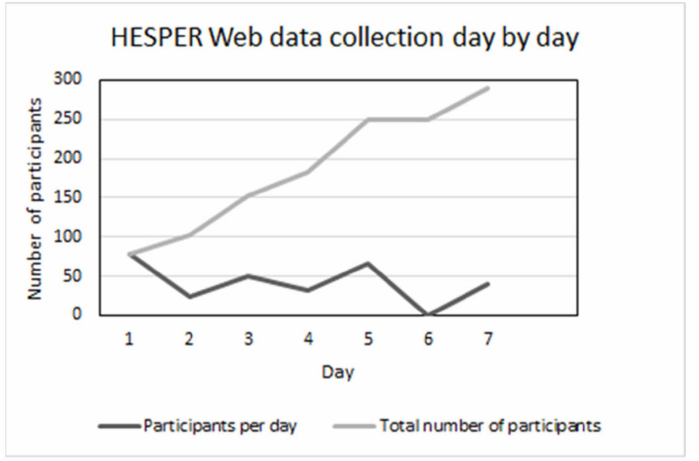
Figure 1. Number of participants per day in the HESPER Web voluntary, self-recruited study